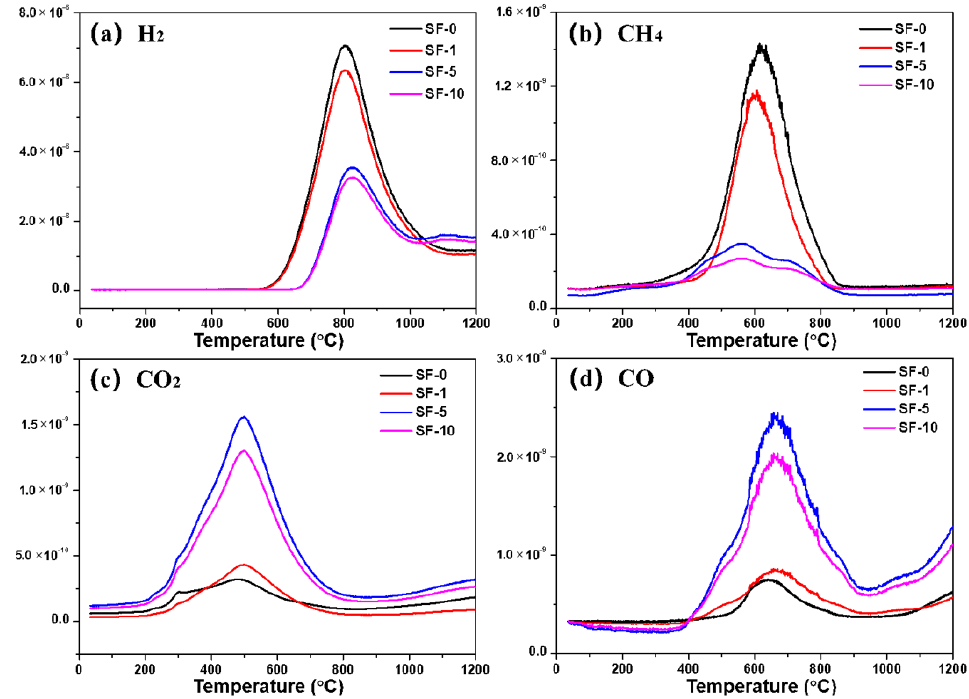
Figure 6. MS curves of different PIM-derived stabilized fibers in argon: ( a ) H 2 ; ( b ) CH 4 ; ( c ) CO 2 ; ( d ) CO.